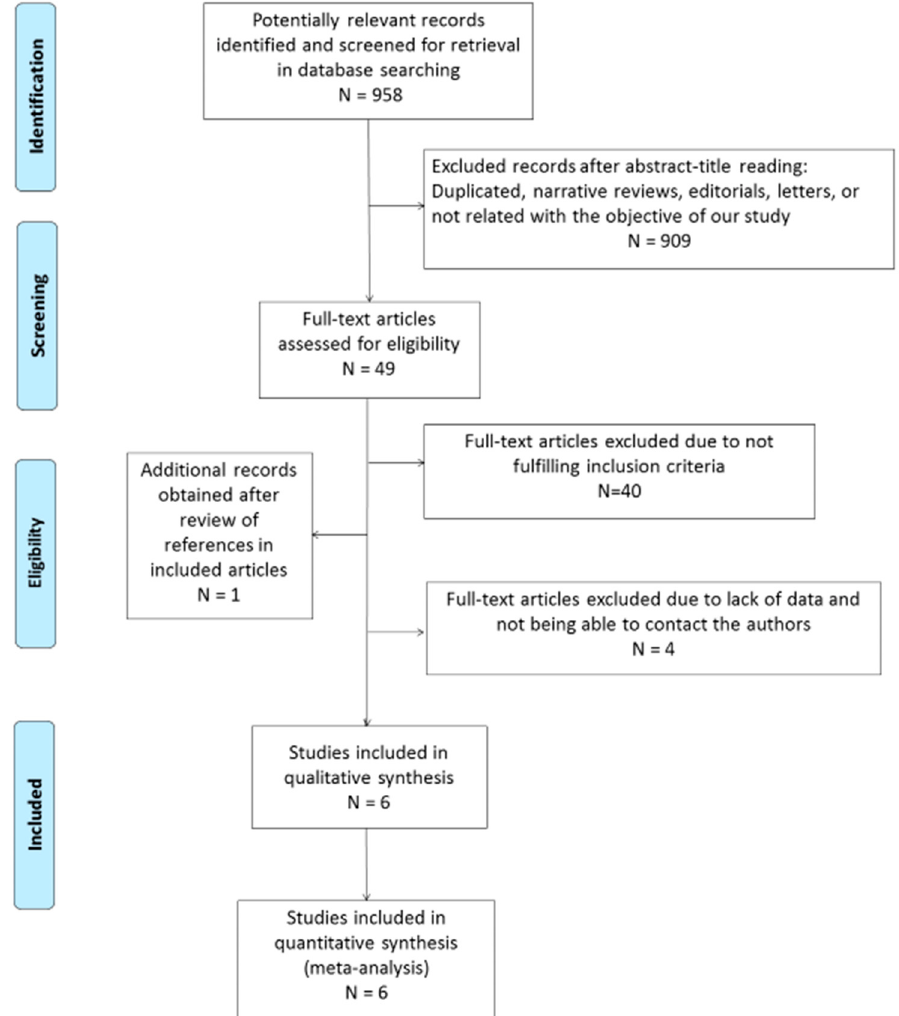
Figure 1. Flow diagram describing the study selection